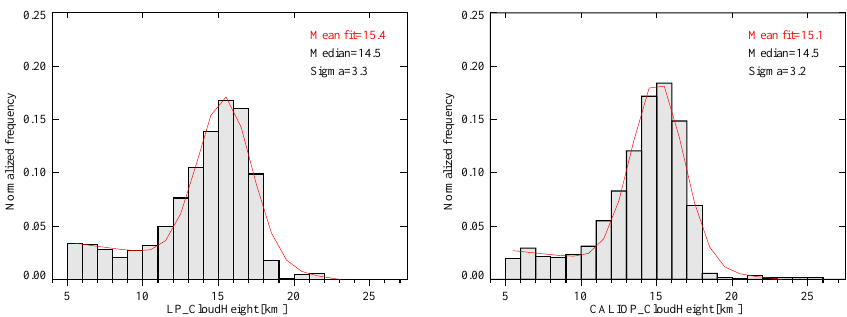
Figure 8. Normalized frequency histograms of all cloud height values from LP cloud detection results (left panel) and the collocated CALIPSO data (right panel) in the tropics (latitude < ± 30 ◦ ) in (cid:49)z cloud = 1km intervals. The red curves represent a linear combination of a Gaussian and quadratic function fit to each data